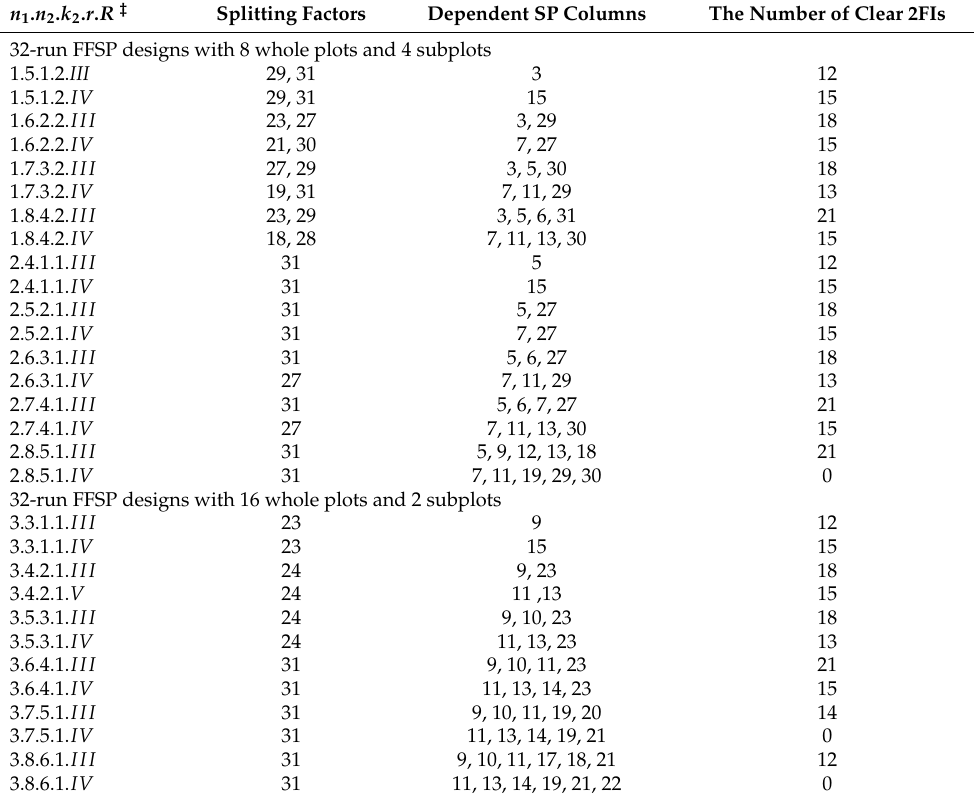
Table 3. example 32-run FFSP designs with splitting factors which have the most clear 2FIs. n 1 . n 2 . k 2 . r . R ‡ Splitting Factors Dependent SP Columns The Number of Clear 2FIs 32-run FFSP designs with 8 whole plots and 4 subplots 1.5.1.2. III